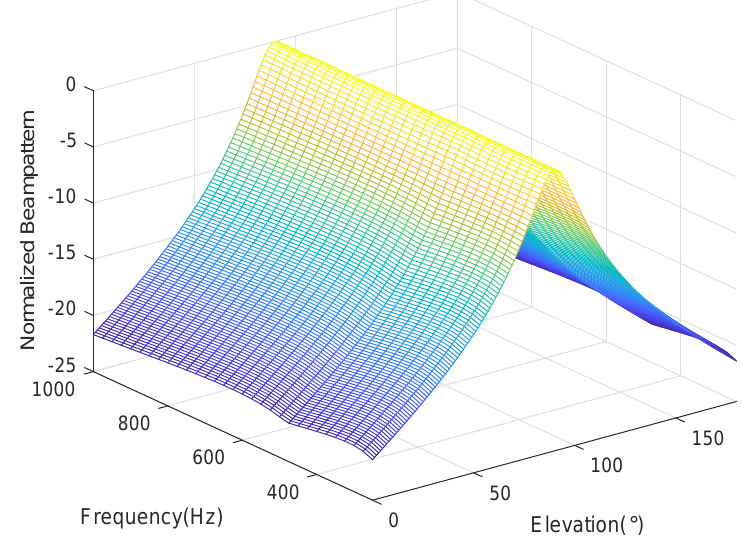
Figure 15. Frequency invariant beampattern over [ 250 Hz ,1000 Hz ] in the elevation plane, where the azimuth angle is fixed to 180 ◦